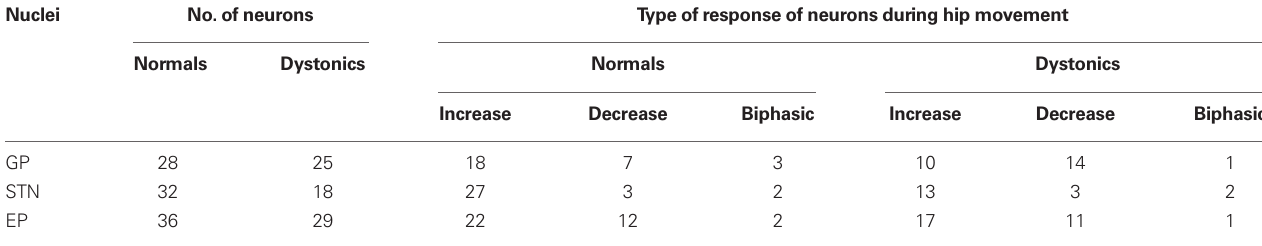
Table 2 | Neuronal responses during hip movement ( n = 7 dystonics, 7 controls).